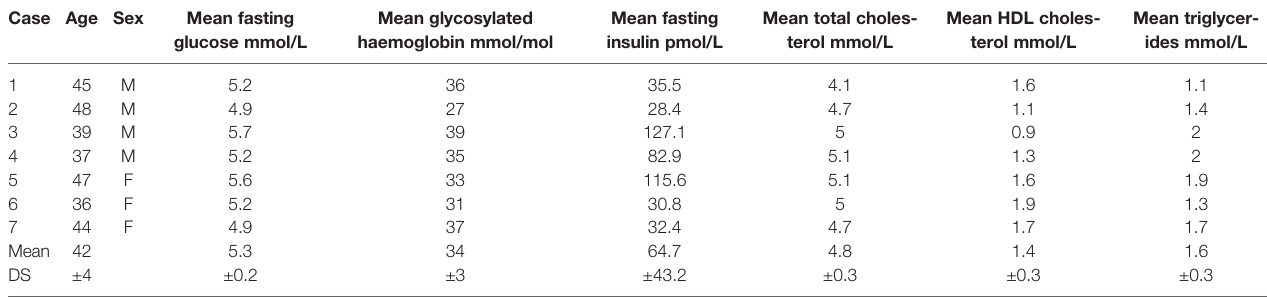
TABLE 1 | Demographical and functional characteristics of enrolled